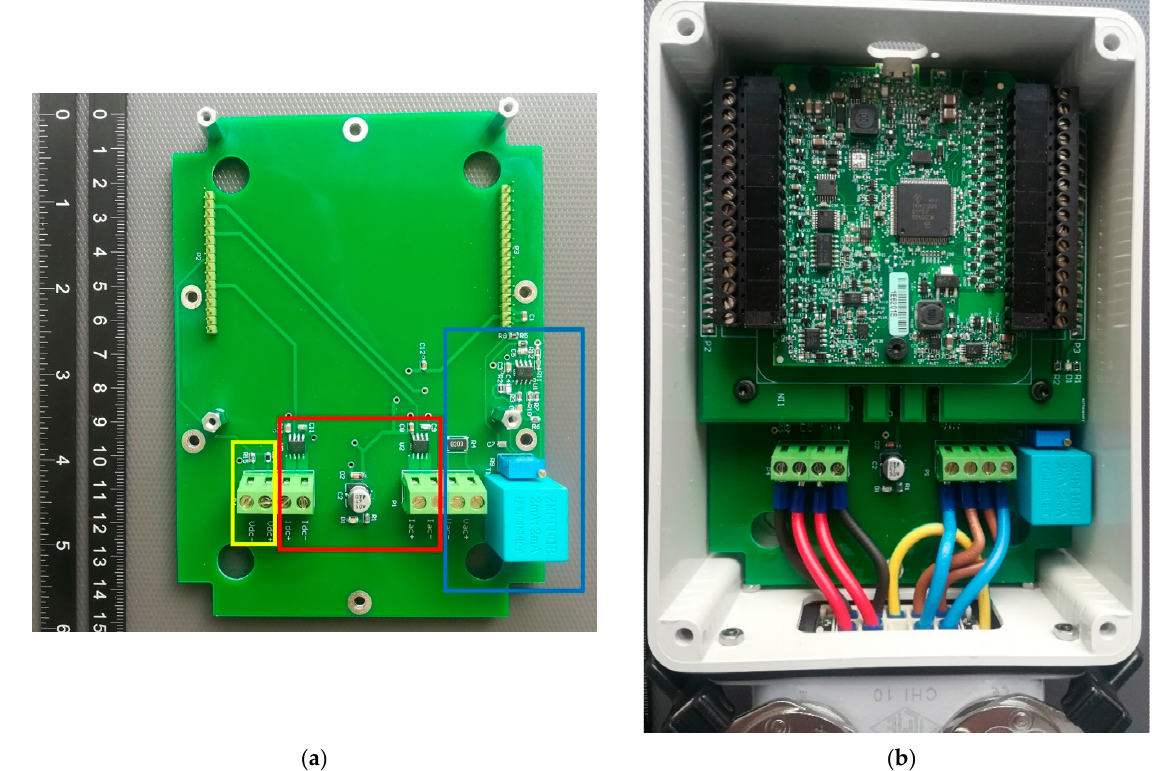
Figure 4. The developed board for signal sensing and acquisition: ( a ) particular of the layer that includes the AC voltage probe (highlighted in the blue box), the two ACS712 current sensors (highlighted with the red box) and the DC voltage probe (highlighted with a yellow box), ( b ) the complete board with the shield including the DAQ board mounted on the probe and sensor